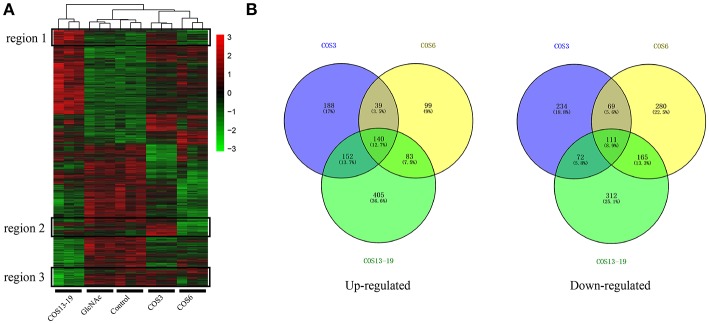
Differentially expressed gene (DEG) analysis of different MW COS-stimulated macrophages (P < 0.001). (A) A heatmap was used to classify the DEG expression patterns in all groups, the x-axis represents the experimental conditions (4 h). (B) Venn diagrams of DEGs in COS3, COS6, and COS13-19 groups. Left panel: up-regulated genes; right panel: down-regulated genes.